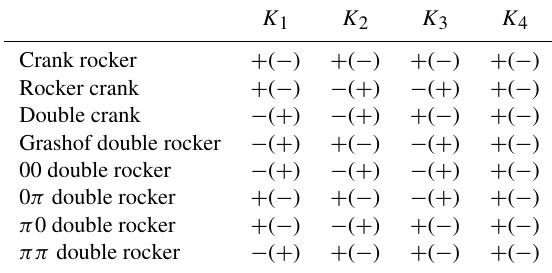
Table 1. Classification of the linkage type (Murray and Larochelle,